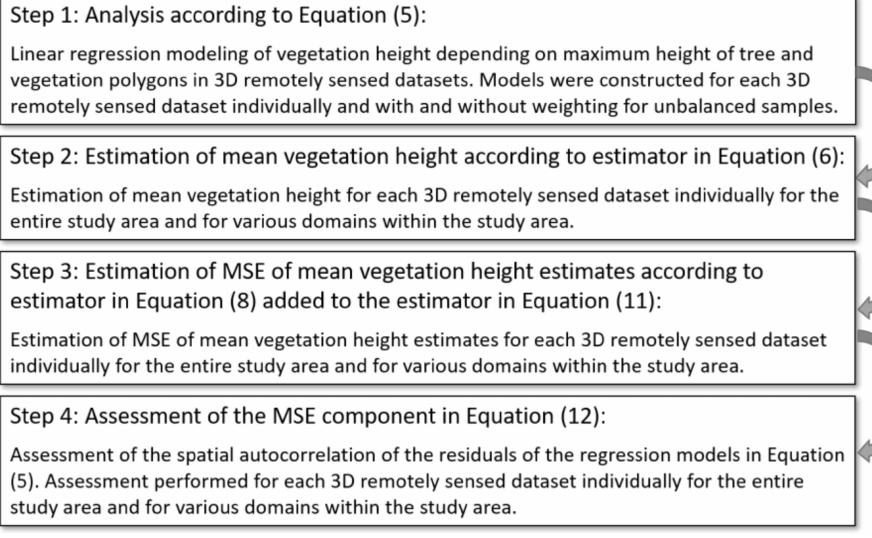
Figure 4. The sequence of analysis steps undertaken to address objective